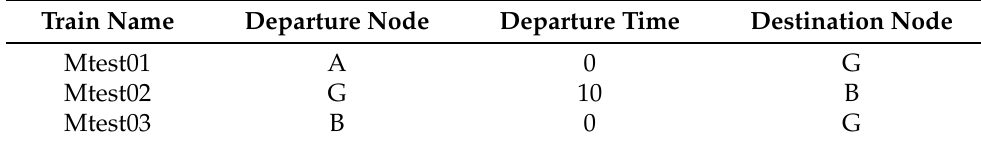
Table 5. Case 3: Train information.